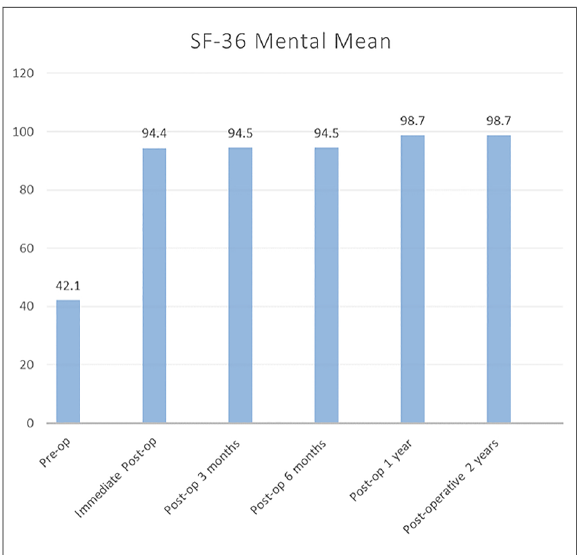
FIGURE 4 FFI mean score for 2 years follow-up. FFI, Foot Function